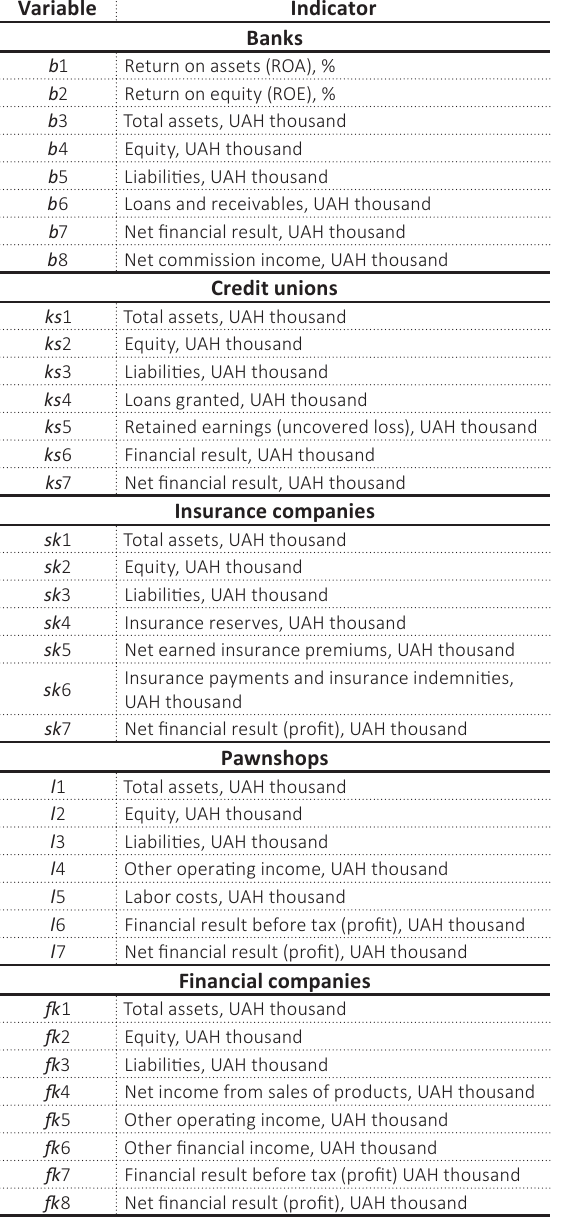
Table 2. Description of input model